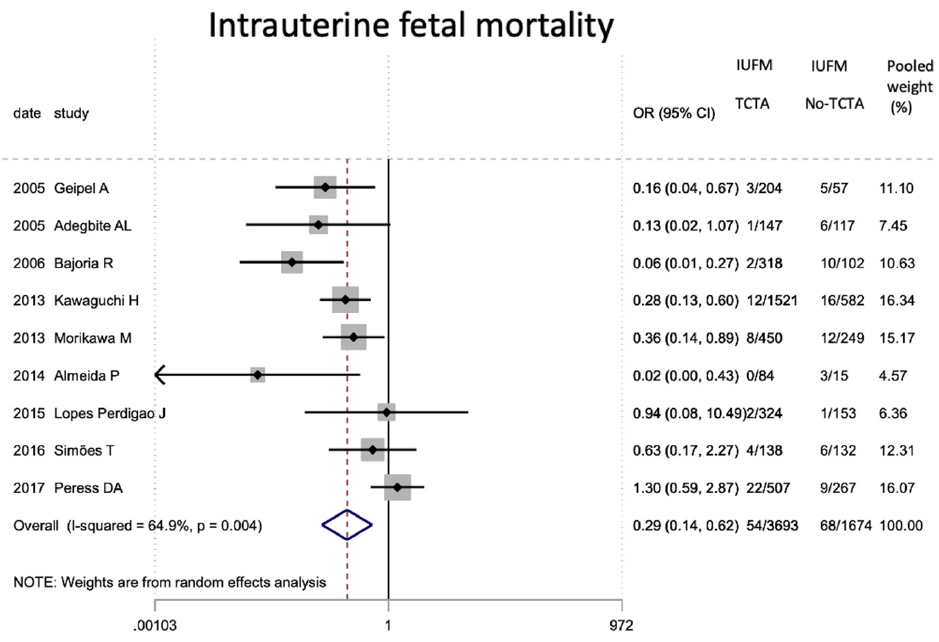
Figure 16. Results of the meta-analysis on the effect of chorionicity (TCTA vs no TCTA) on neonatal mortality. NNM: neonatal mor-tality; TCTA: trichorial-triamniotic, non-TCTA: non-trichorial- triamniotic. OR = odds ratio, CI = confidence interval. 4. Discussion 4.1. Main Findings Both our systematic review and meta-analysis collected data on a wide range of outcome measures from a large population sample. This systematic review brings together a large population sample from a large number of studies (46 studies with a total of 43,653 triplet pregnancies and 128,145 live births), collecting information on 47 variables [14,16,21,24–66]. Similarly, this meta-analysis included many articles with a large total population sample (12 studies, 2188 pregnant women, 5790 fetuses, and 5441